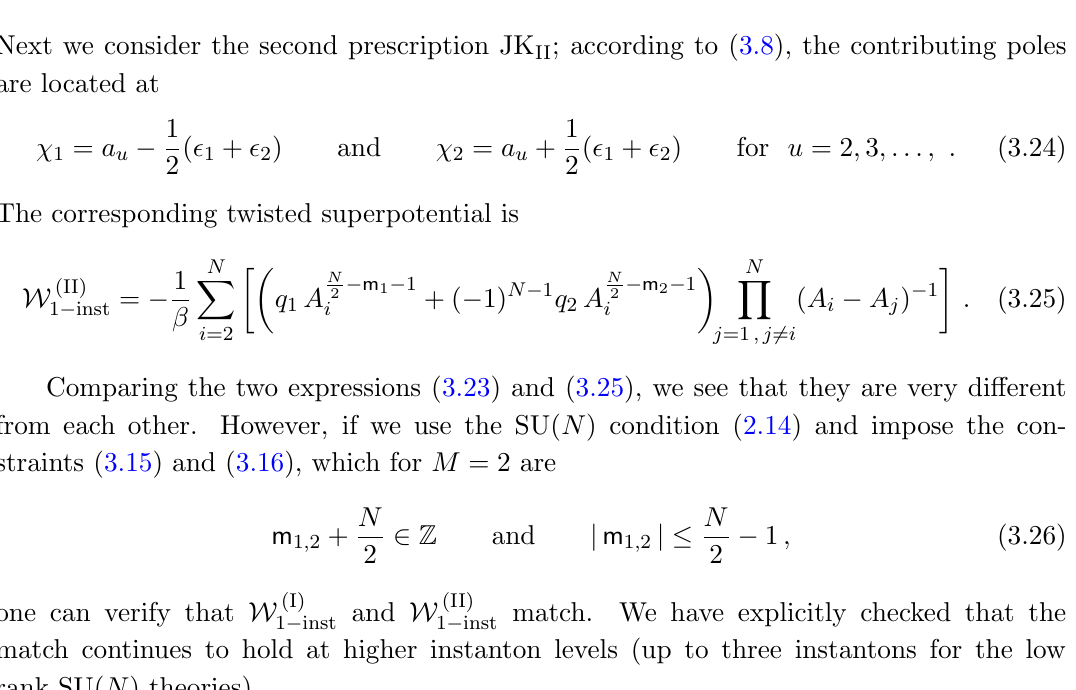
Figure 7 . The quiver that describes the generic surface operator in pure SU( N ) gauge